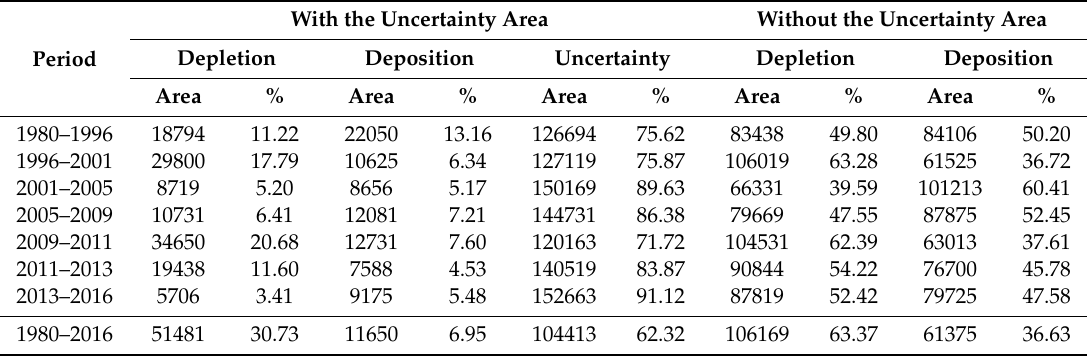
Table 5. Areas a ff ected by the gullies: depletion and deposition 1